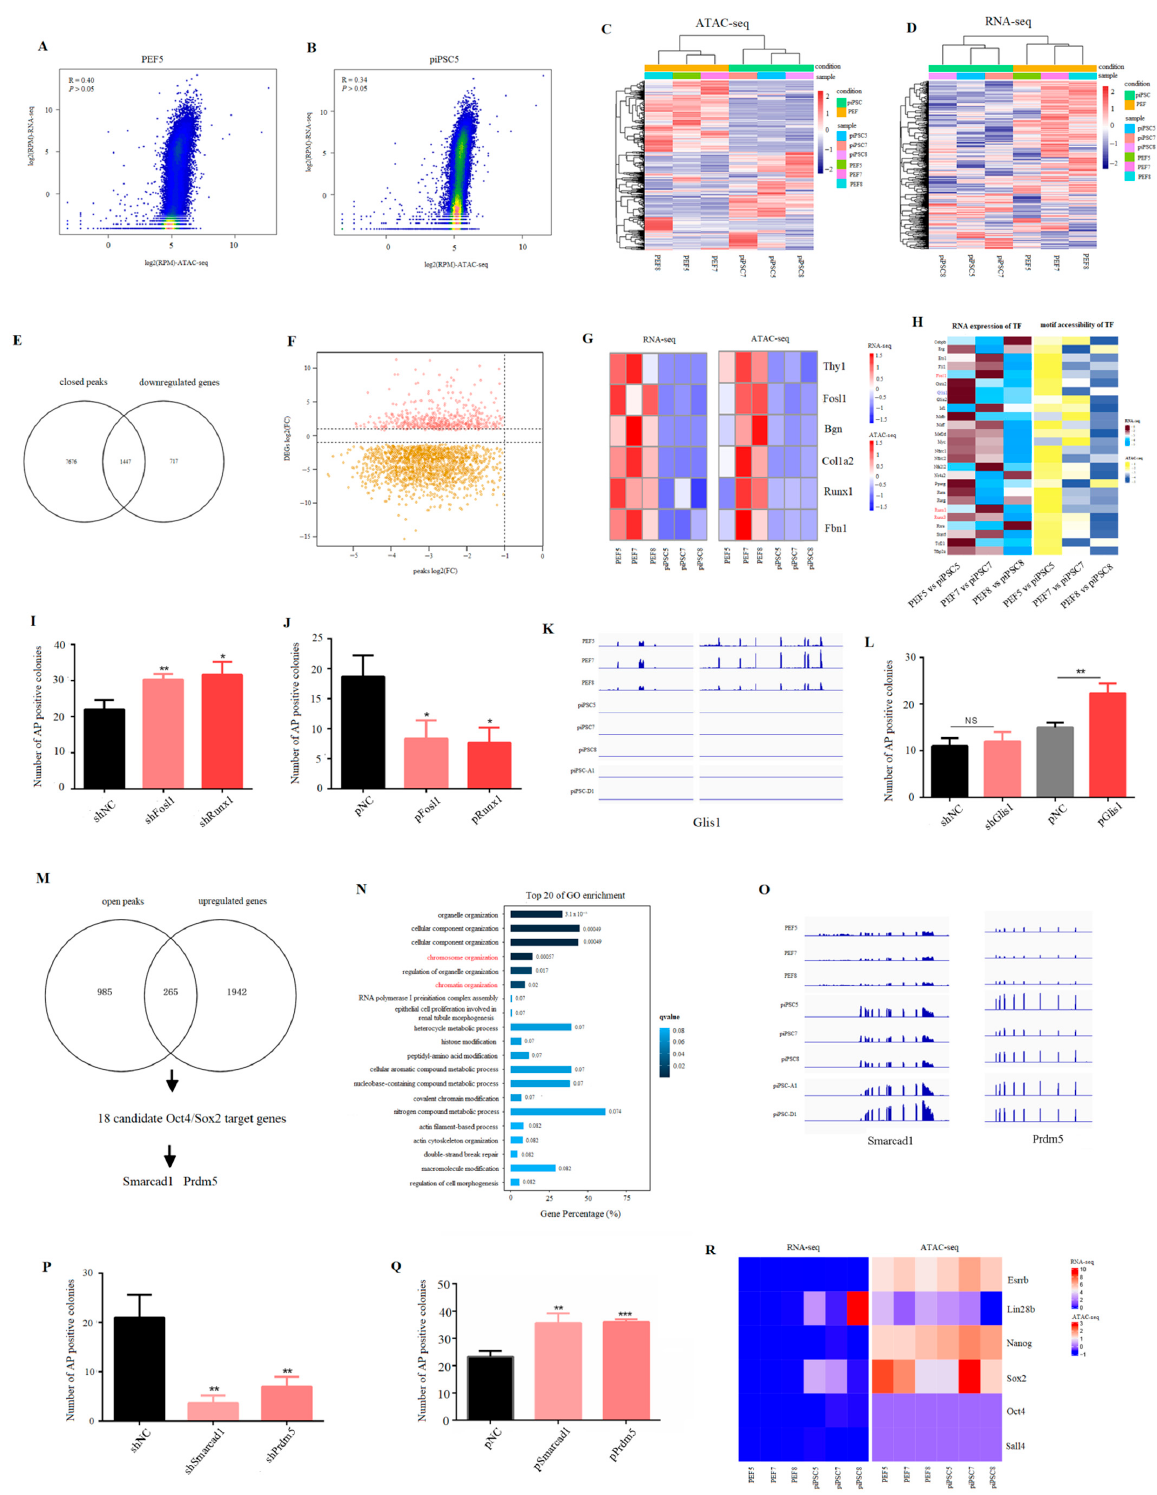
Figure 3. Effect of accessible chromatin on gene expression. ( A , B ) Scatter plots showing the correlation between ATAC ‐ seq data and RNA ‐ seq data in PEF5 and piPSC5. ( C ) Heatmap cluster of